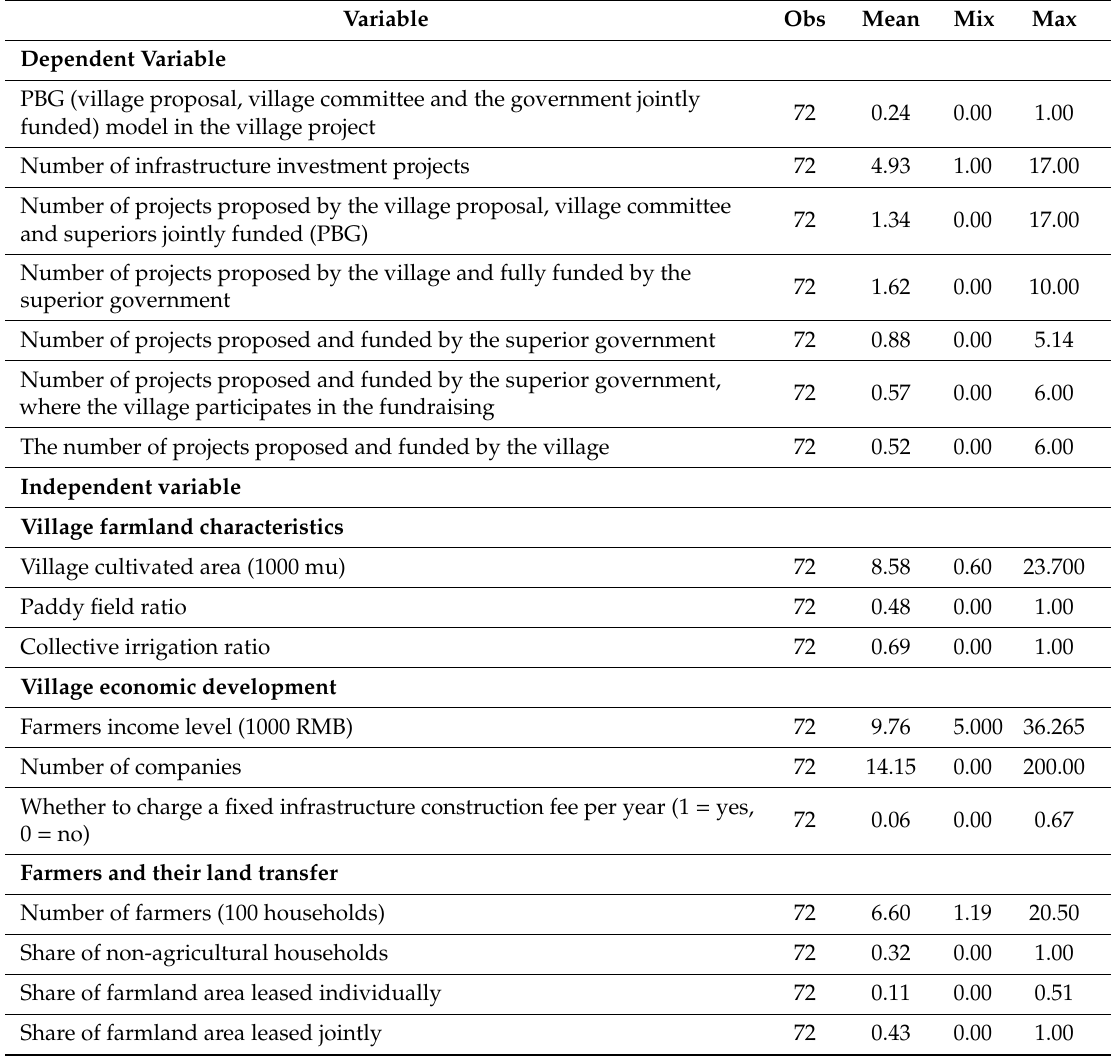
Table 1. Descriptive statistics for